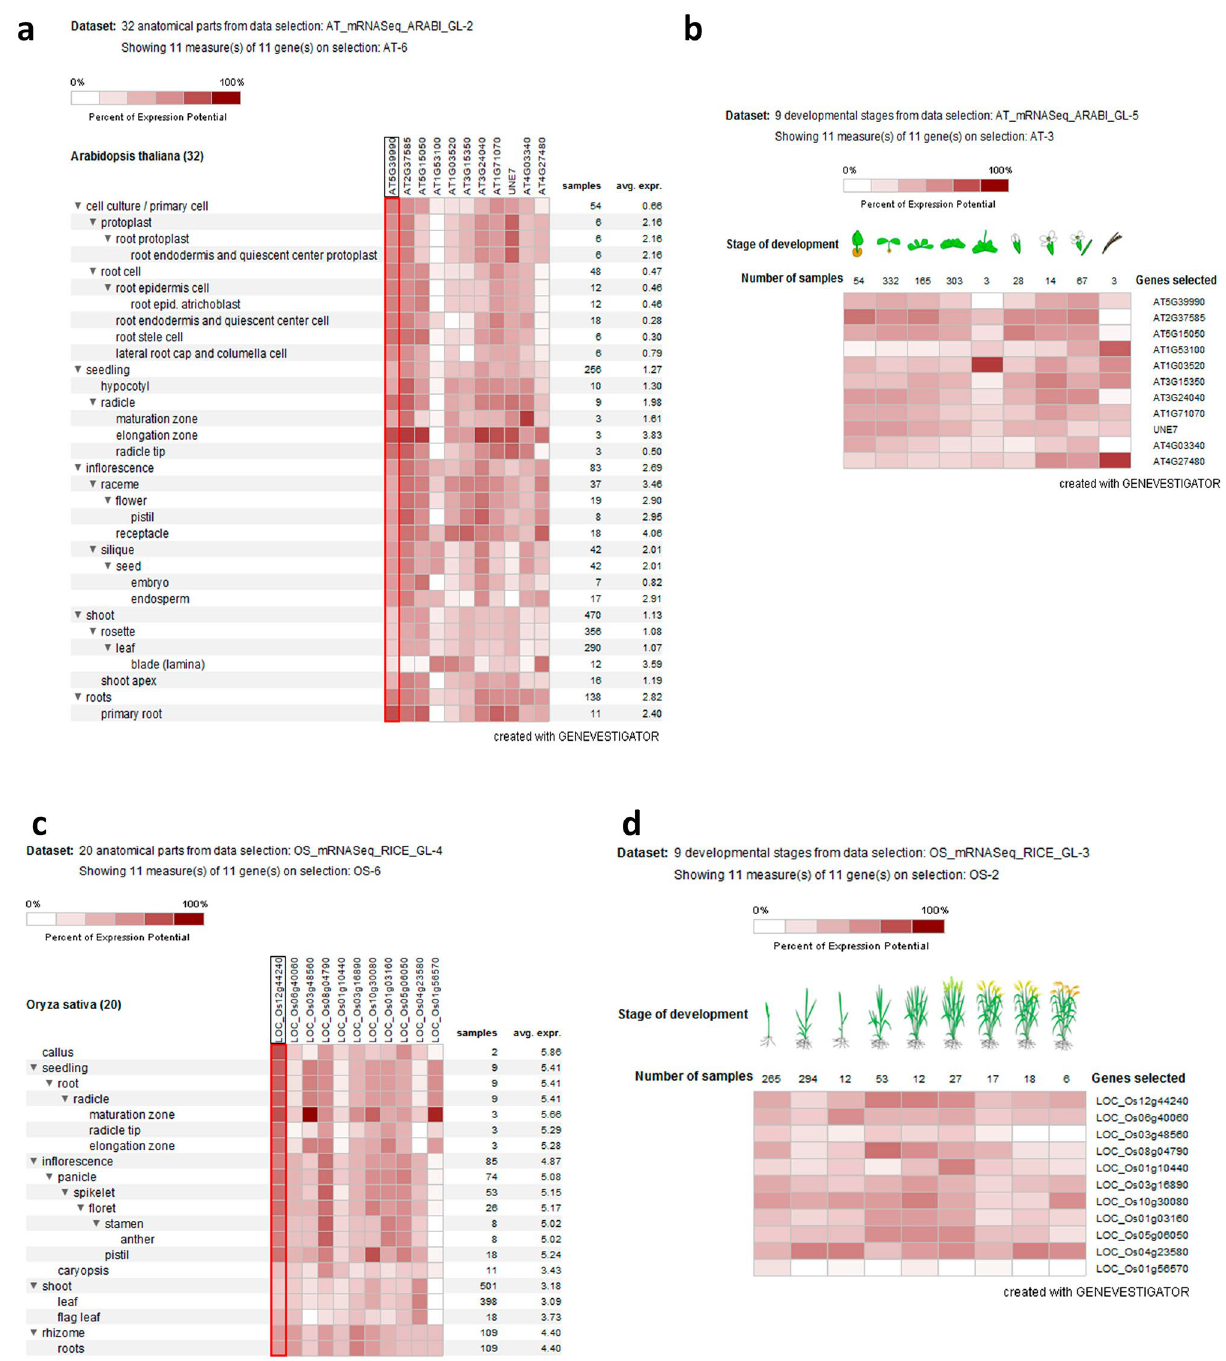
Figure 5. Expression pattern of putative GLCAT genes across anatomical reference points and developmental stages in Arabidopsis, rice and soybean. Figure showed the digital expression pattern in the anatomical parts and across developmental stages of Arabidopsis ( a , b ), rice ( c , d ) and soybean ( e , f ). The red boxed region corresponds to the functionally characterized AtGLCAT14A (AT5g39990) gene ( a ) and its orthologs in rice ( c ) and soybean ( e ) 11